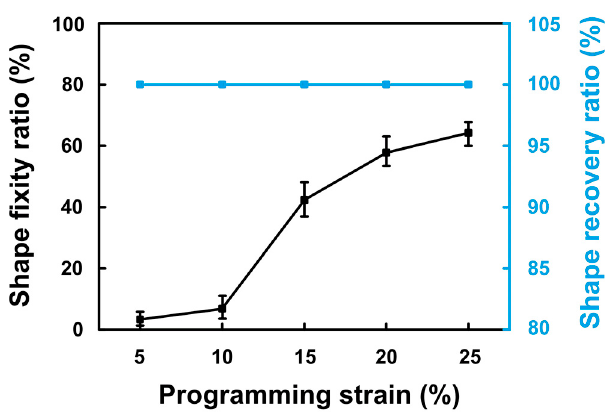
Figure 7. Shape fixity ratio and shape recovery ratio upon heating to 180 °C versus programming strain relationships for samples programmed at room temperature.